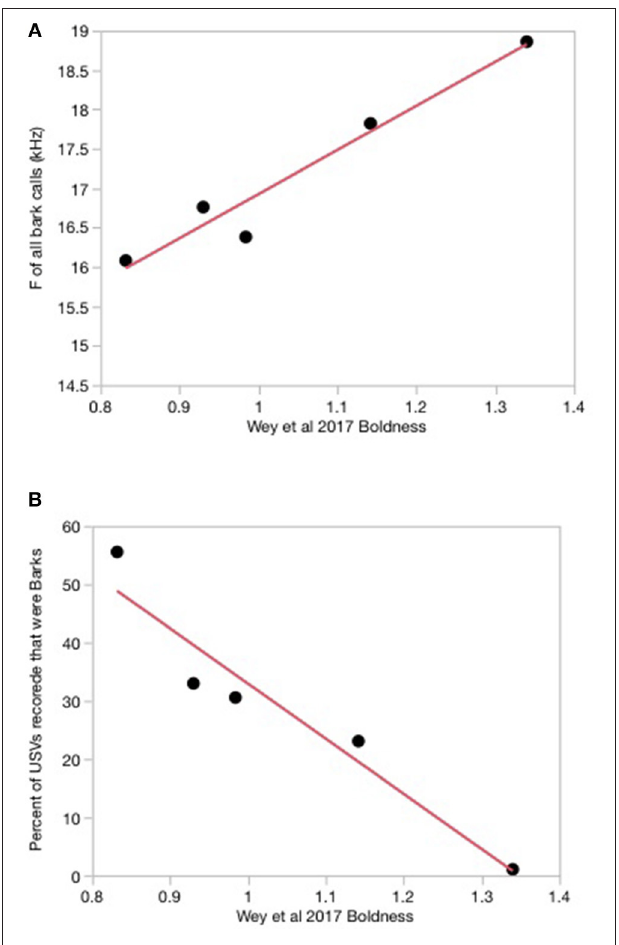
FIGURE 2 | Significant relationships between the trait of boldness from Wey et al. (2017) and bark USVs recorded from 5 species at the Peromyscus Genetic Stock Center in 2006. Species represented, and boldness values are in Figure 1. (A) Linear Fit: F of all bark calls = 11.32 + 5.60* Boldness; F = frequency at maximum amplitude. (B) Linear Fit: Percent of calls that were Barks = 127.60 – 94.63*Boldness.